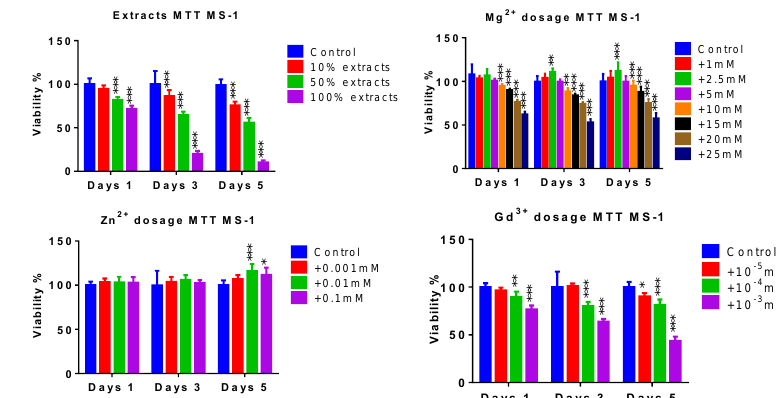
Figure 3. Cytotoxicity of alloy extracts Mg ions, zinc ions, and gadolinium ions. ( A ) The cell viability of the pre-osteoblast cell line, MC3T3E − 1; (B) the cell viability of the fibroblast cell line L929; ( C ) the cell viability of the endothelial cell line, MS − 1, n = 8, t -test between control and each group, * p < 0.05, ** p < 0.01, *** p < 0.001. Table 1. Alizarin Red staining positive area.